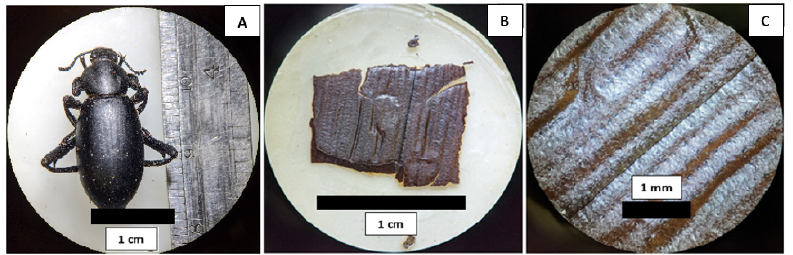
Figure 2. ( A ) Dorsal view of one, individual E. eschscholtzii collected from HMO. Channel-patterned structures of the external surface observed with a stereoscopic microscope at no magnification ( B ) and 8X ( C ).